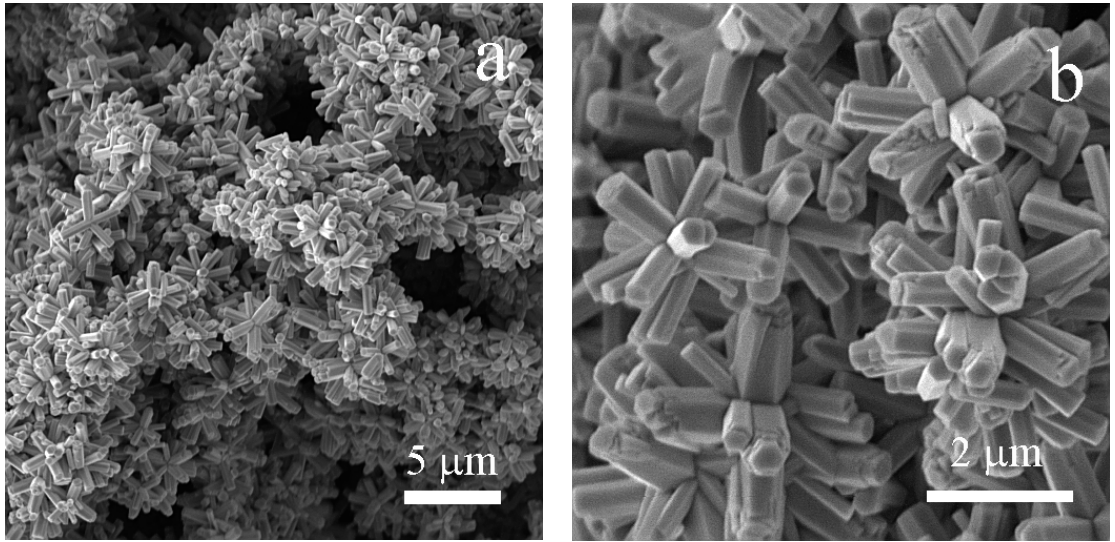
Figure 2. Scanning electron microscopy (SEM) images ZnO star-like particles under various magnifications: ( a ) 5000× and ( b ) 20,000×.